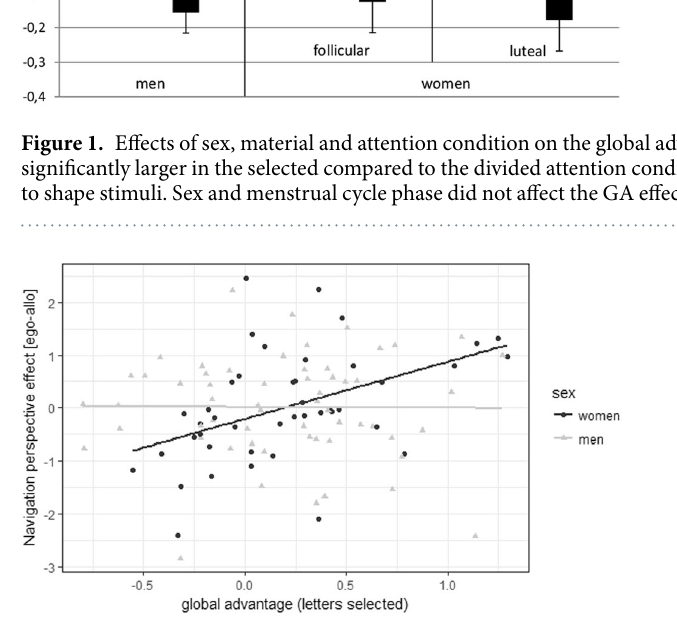
Figure 2. Relationship of the GA effect to the perspective effect in the 2D matrix navigation task. A larger GA effect in the letters selected condition was related to better performance with allocentric as compared to egocentric instructions in the navigation task in women, but not in